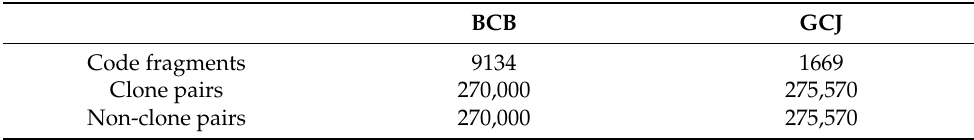
Table 1. Basic information about BCB and GCJ in our